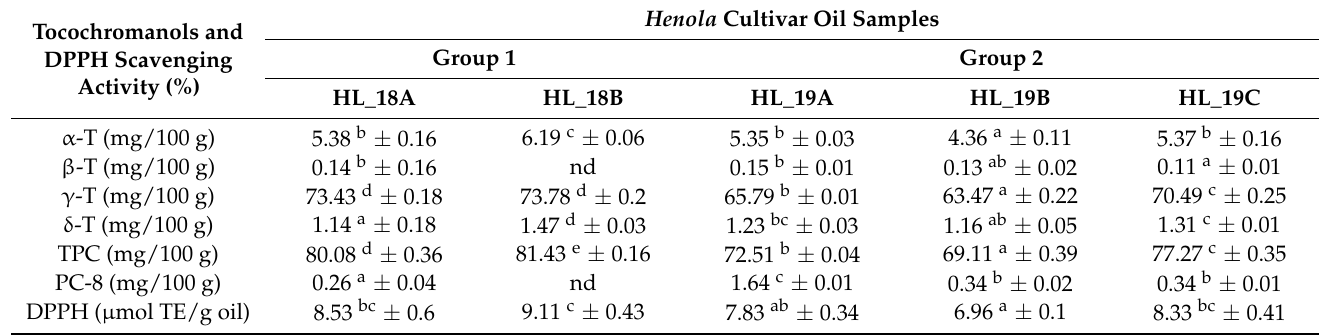
Table 3. Tocochromanols contents of cold-pressed hemp seed oils and antioxidant activity determined by measuring DPPH radical scavenging activity (%